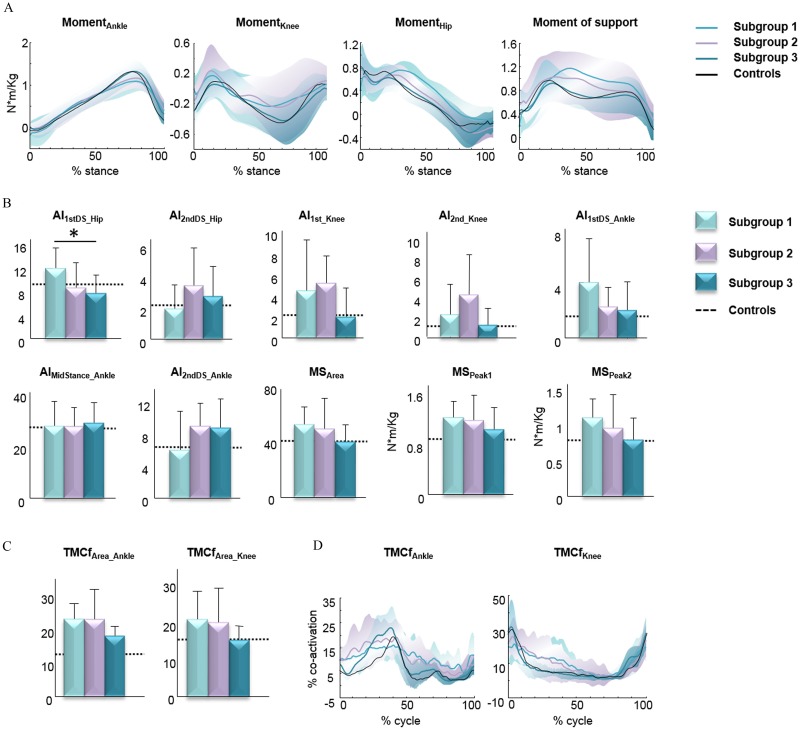
Joint kinetic and muscles parameters in HSP subgroups.(A) Mean (with SDs in light colors) kinetic plot of joint moments (hip, knee and ankle) and support moment. The patterns are normalized to body weight and plotted vs. normalized stance. (B) Mean values (±SD) of kinetic parameters. (C) Mean TMCfArea (±SD) calculated for ankle and knee muscles (TMCfArea_Ankle and TMCfArea_Knee). (D) Mean (with SDs in light colors) plot of co-activation of ankle and knee joint antagonist muscles during the gait cycle. Mean values of healthy controls for kinetic and muscles parameters are reported in each bar graph (dotted line) and plot (black line). Asterisks indicate significant differences among the three subgroups at post hoc analysis (* p<0.05).